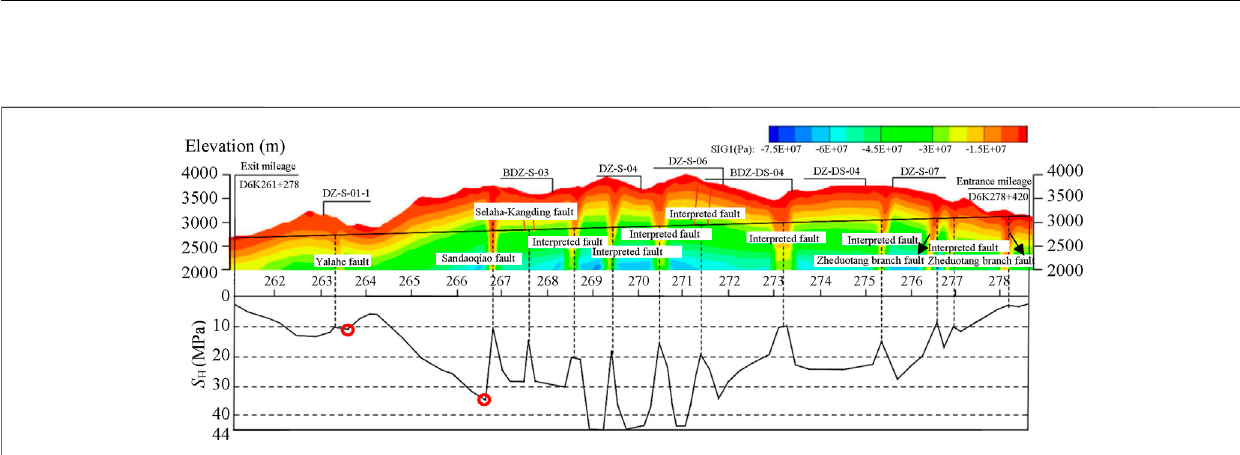
Frontiers in Earth Science |